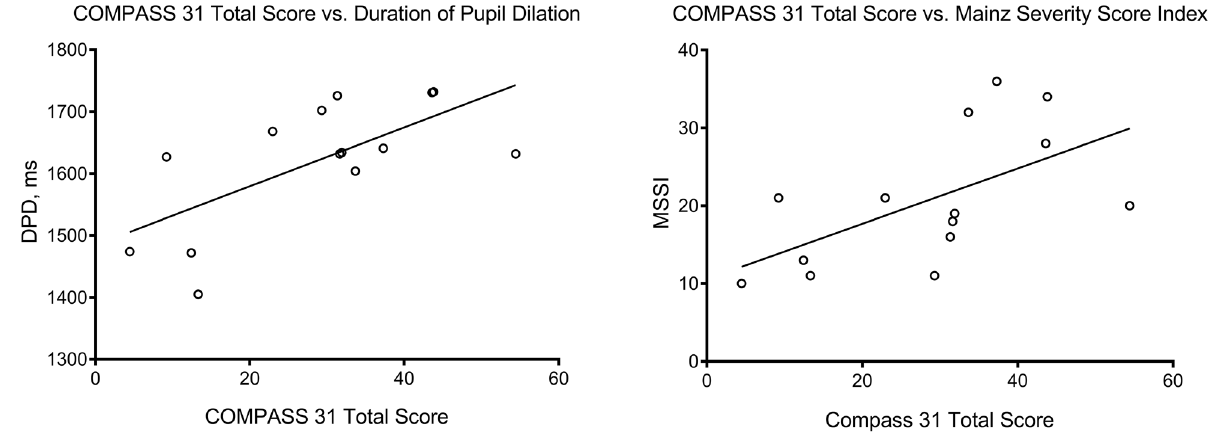
Figure 2. Scatter-plot graphs showing a significant correlation of COMPASS 31 total score with the duration of pupil dilation (ρ = 0.561; P = 0.037) and MSSI ( r = 0.592; P =